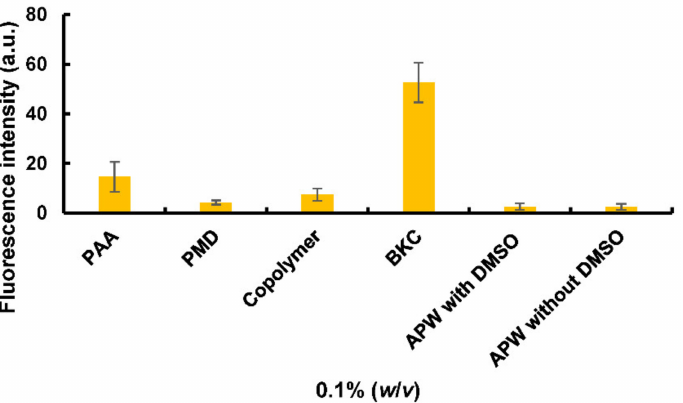
Figure 8. Fluorescence intensity (per cm 2 ) of individual planaria exposed to different test substances. Data are expressed as mean ± standard deviation ( n = 3).